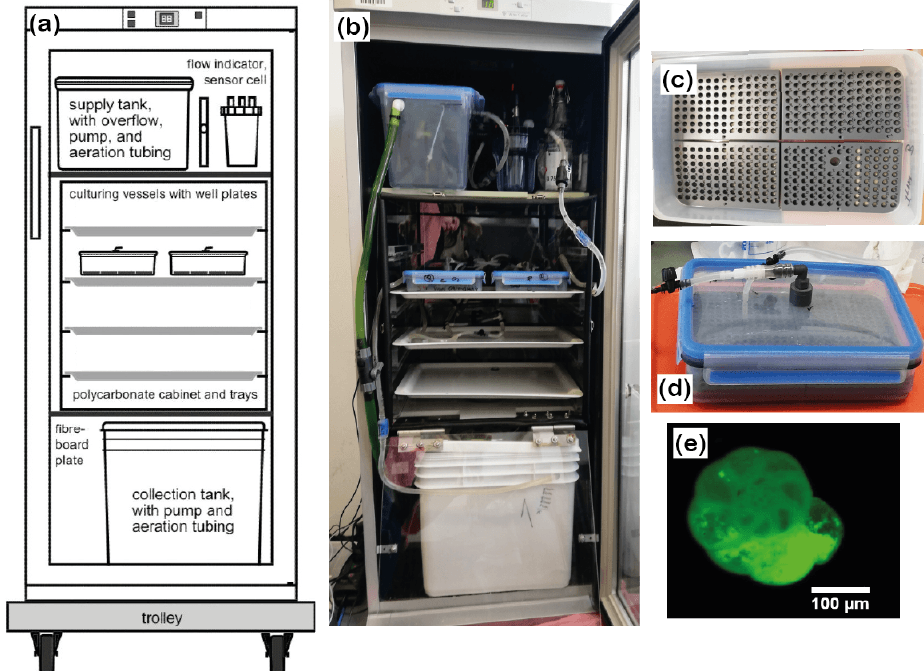
Figure 2. Culturing setup. (a) Conceptual draft and (b) assembly of the system. Tubing and hoses were omitted from the draft for clarity. (c) A well plate with mounted specimens and sand; (d) closed culturing vessel with well plates and conduits. (e) Calcein-stained foraminifer under a fluorescence microscope. Please note that the last 2.5 chambers are labelled and fluorescing brightly. The specimen shown in the picture was dead, cleaned and dried, which ensured that the test itself and not the cytoplasm showed the fluorescence.